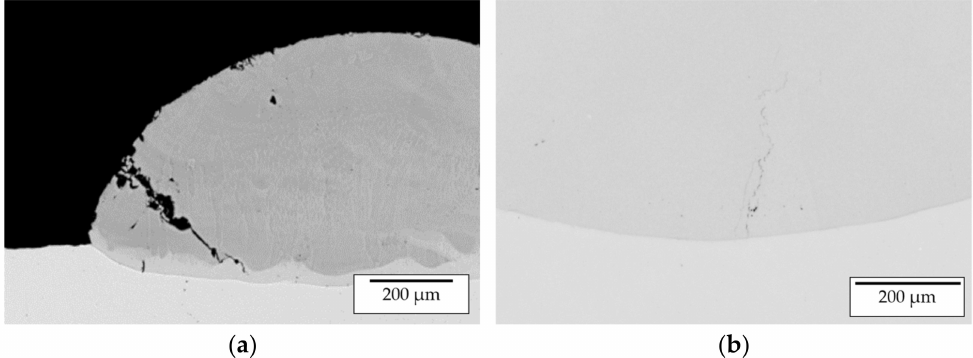
Figure 10. ( a ) Cold cracking due to processing without substrate pre-heating; ( b ) hot crack formation within single